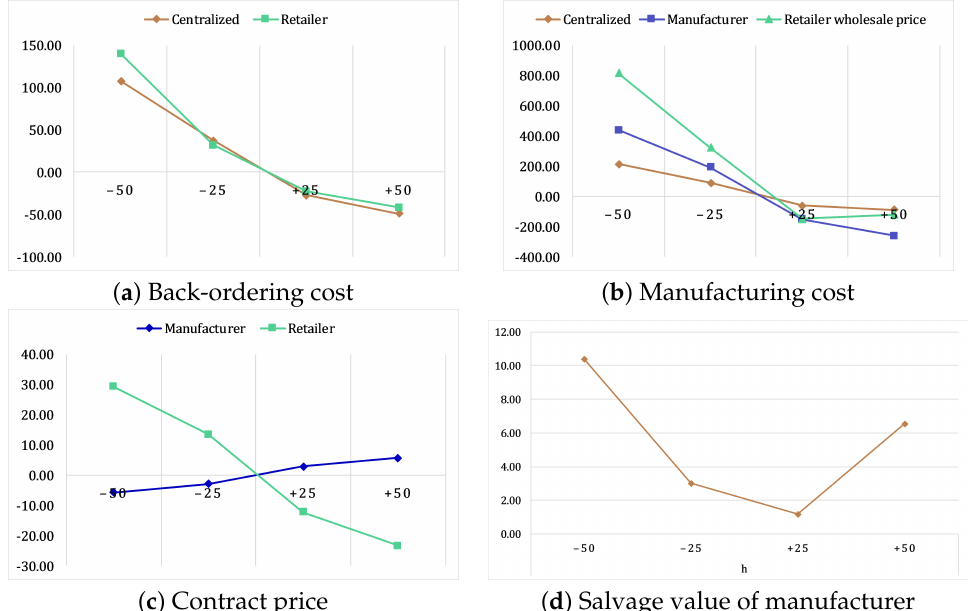
Figure 6. Graphical representation of sensitivity of key